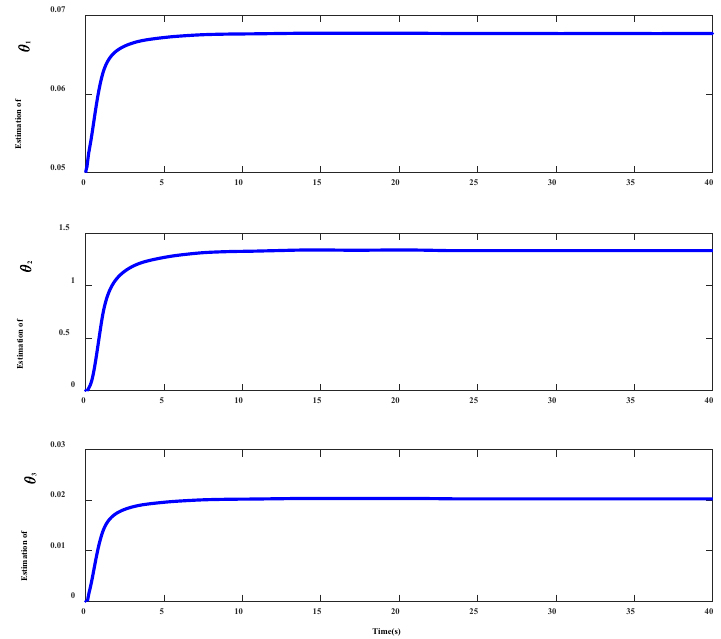
Figure 5. The parameter estimations of θ 1 ~ θ 3 with the ADRAC.